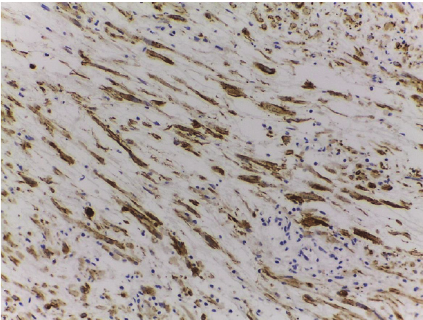
Figure 3: Histological examination of the second case (magnifica- tion 10 × 20), positive ALK-1 staining.